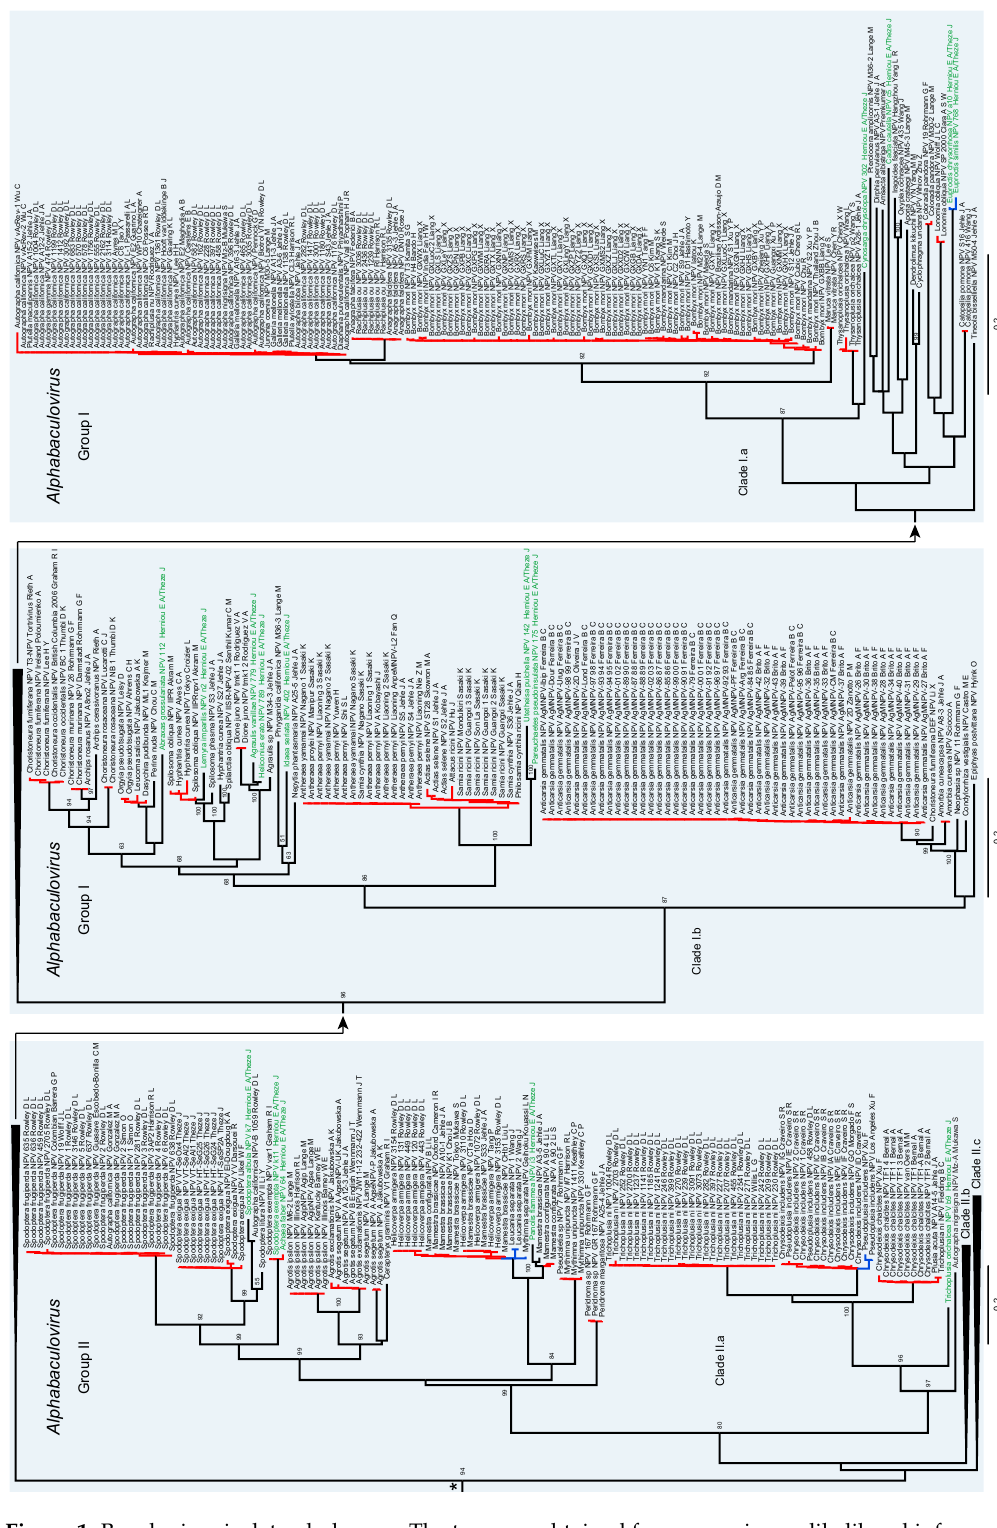
Figure 1. Baculovirus isolate phylogeny. The tree was obtained from a maximum likelihood inference analysis of the concatenated codon-based alignment (794 taxa) of four lepidopteran baculovirus core genes with the baculovirus core-genome phylogeny used as backbone tree (Figure S1). External clades colored in red correspond to clusters determined by both the mPTP (Figure S3) and SpDelim (Figure S4) species delimitation analysis and in blue the clusters not determined by SpDelim. The two star